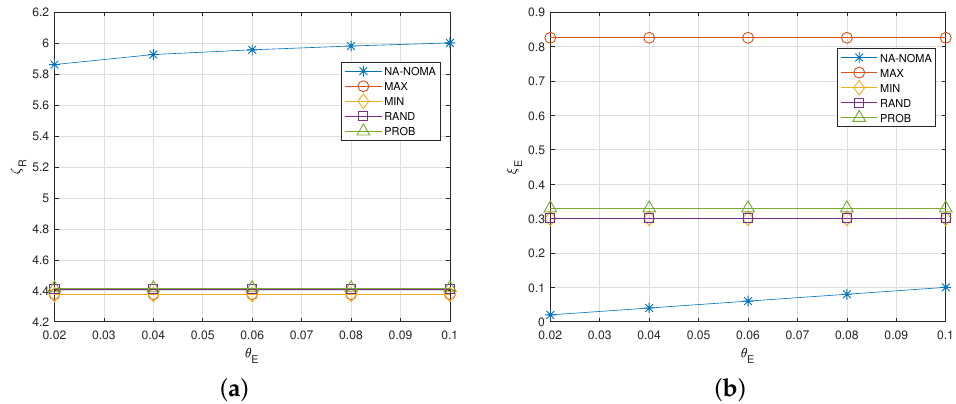
Figure 4. Effect of θ E . ( a ) Average aggregated data rate. ( b ) Energy outage